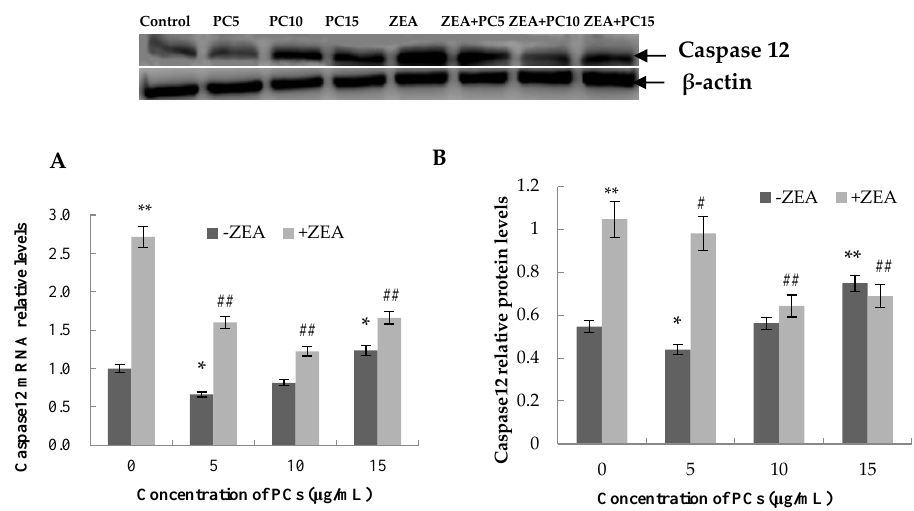
Figure 15. Effects of different concentrations of proanthocyanidins (PCs) on zearalenone (ZEA)-induced relative expression of mRNA ( A ) and cysteinyl aspartate specific proteinase 12 (caspase-12) protein ( B ) in MODE-K cells. When the concentration of PCs was 10 µ g/mL, PCs could significantly decrease the increase in expressions induced by ZEA. * p < 0.05 and ** p < 0.01 vs. control group; # p < 0.05 and # # p < 0.01 vs. ZEA-treated